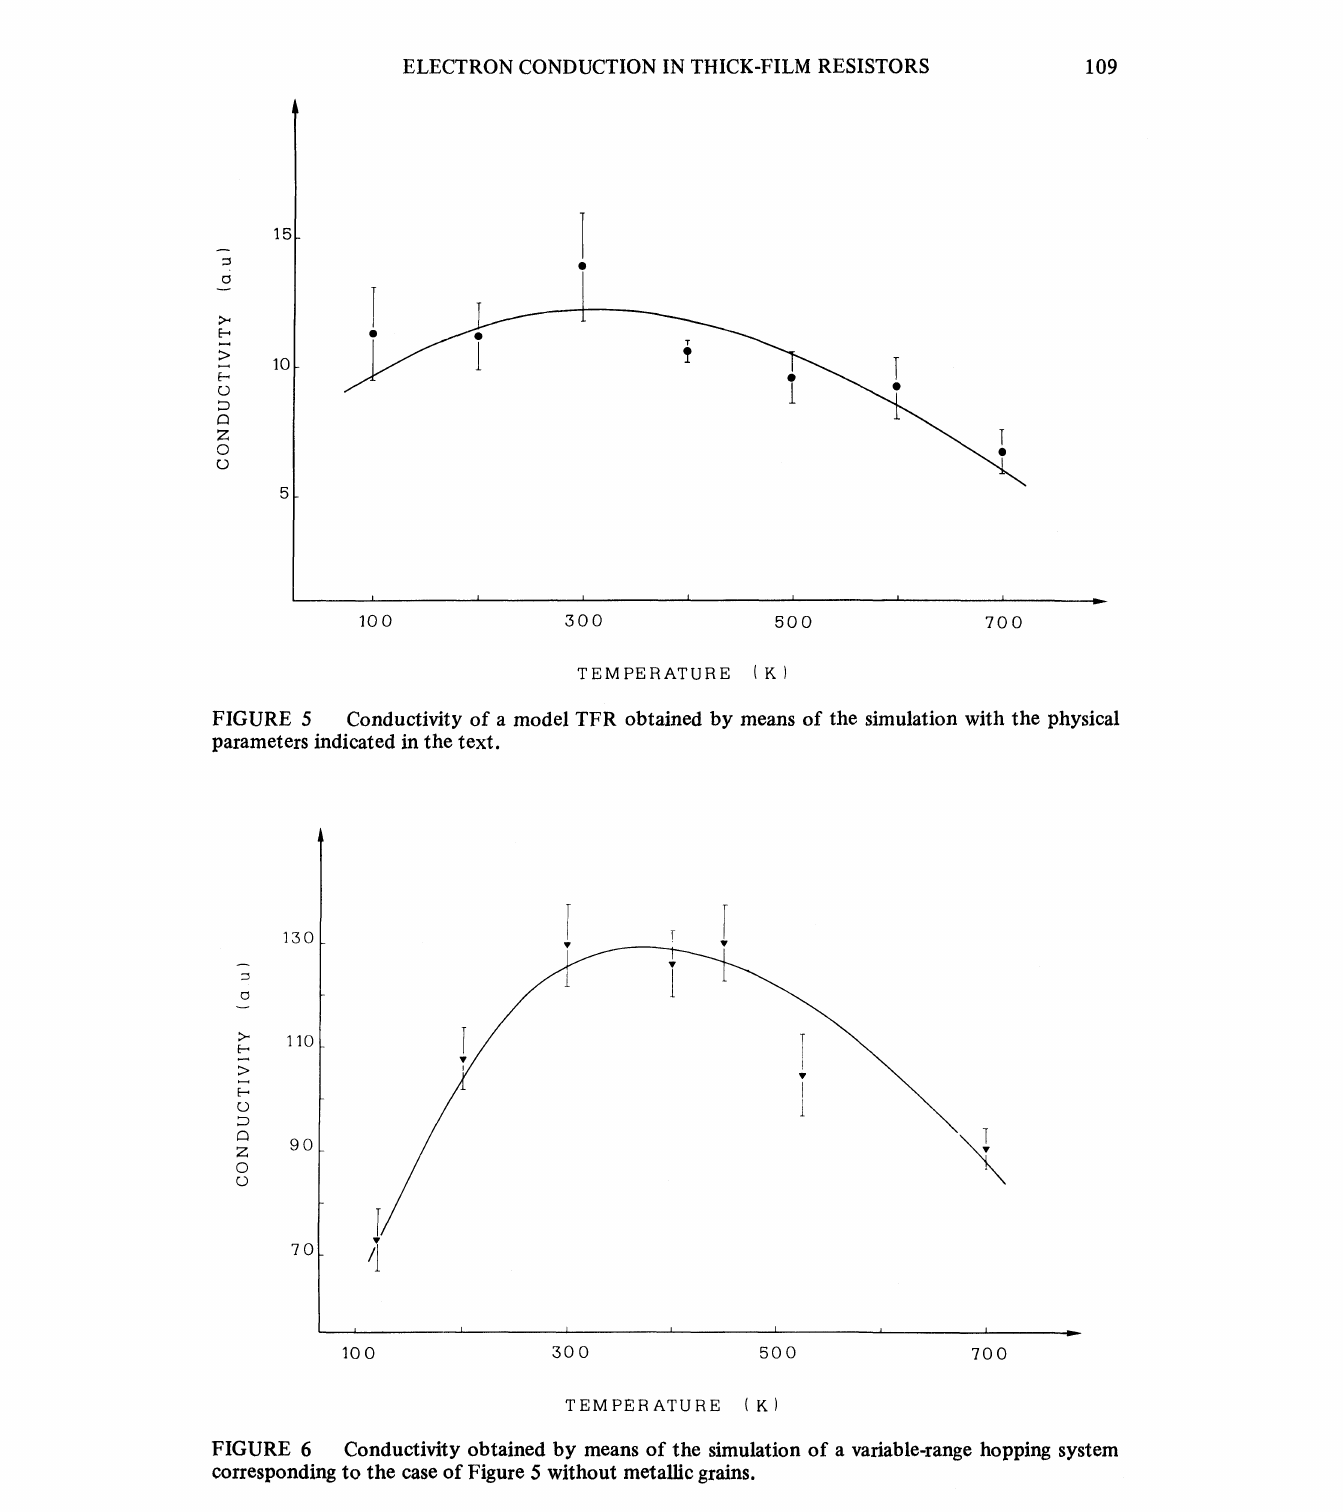
Conductivity obtained by means of the simulation of a variable-range hopping system corresponding to the case of Figure 5 without metallic